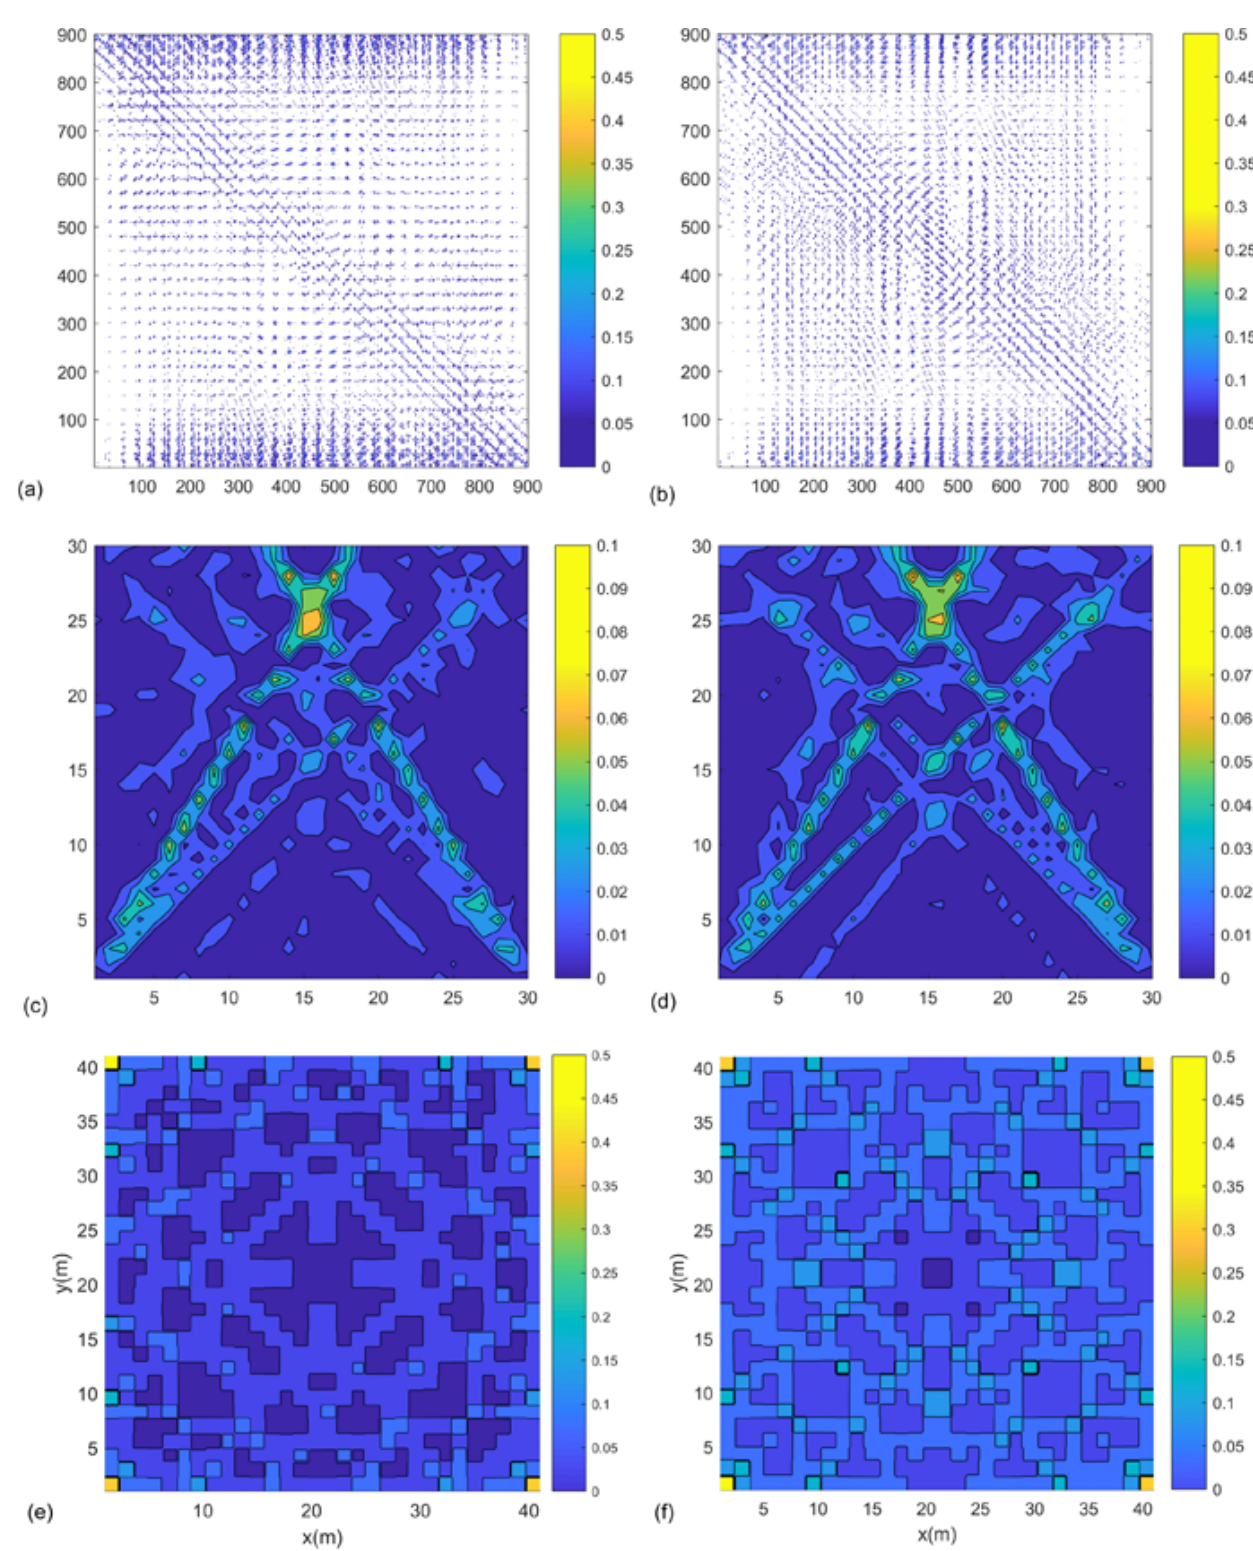
Figure 4. Contour plot of the averaging kernel matrix for (a) the LTD algorithm (b) the MC algorithm. A 2-D display of the row vector of the 106th pixel in the averaging kernel matrix for (c) the LTD algorithm and (d) the MC algorithm. A 2-D display of the diagonal elements of the averaging kernel matrix for (e) the LTD algorithm and (f) the MC